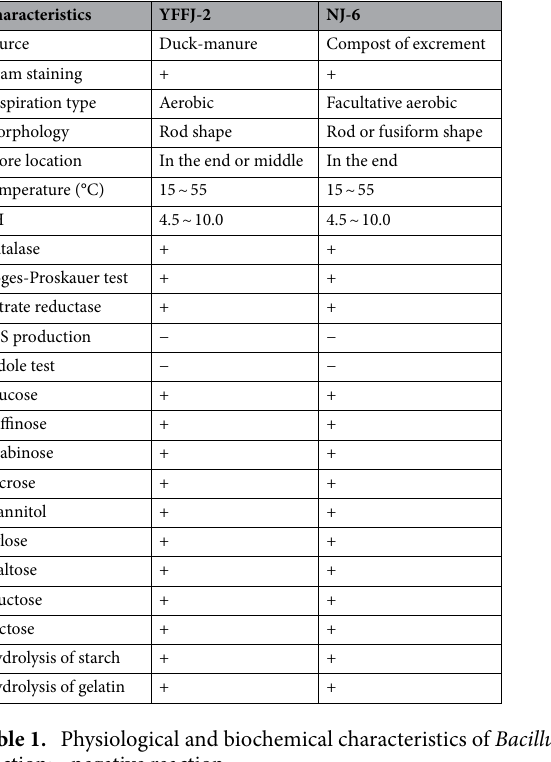
Table 1. Physiological and biochemical characteristics of Bacillus strain YFFJ-2, NJ-6 strain. + positive reaction; −negative